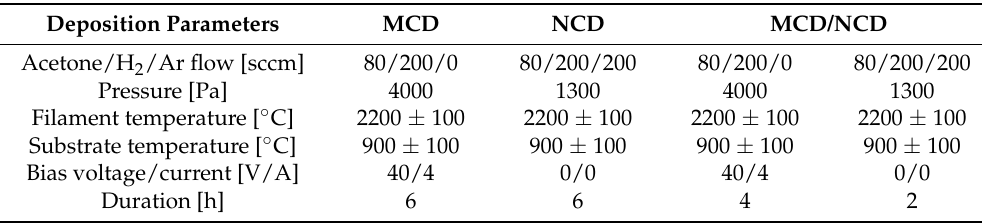
Table 1. Detailed deposition